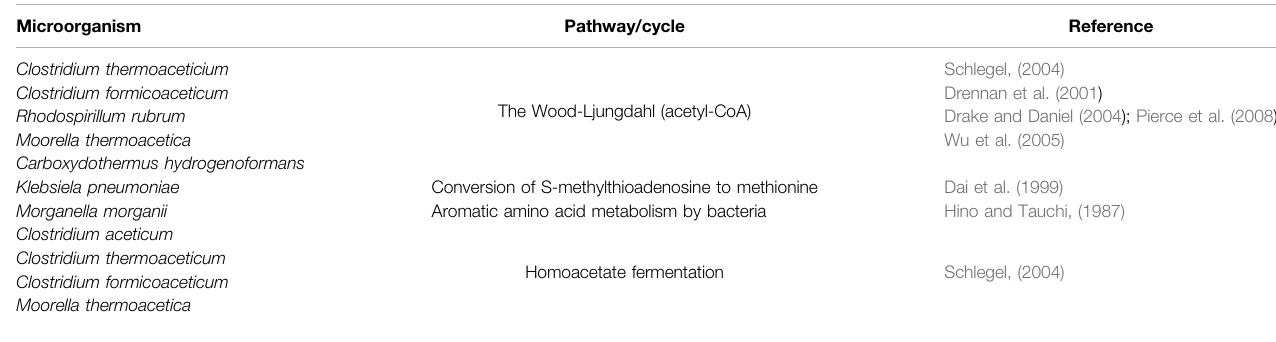
TABLE 3 | Microorganisms involved in different CO production